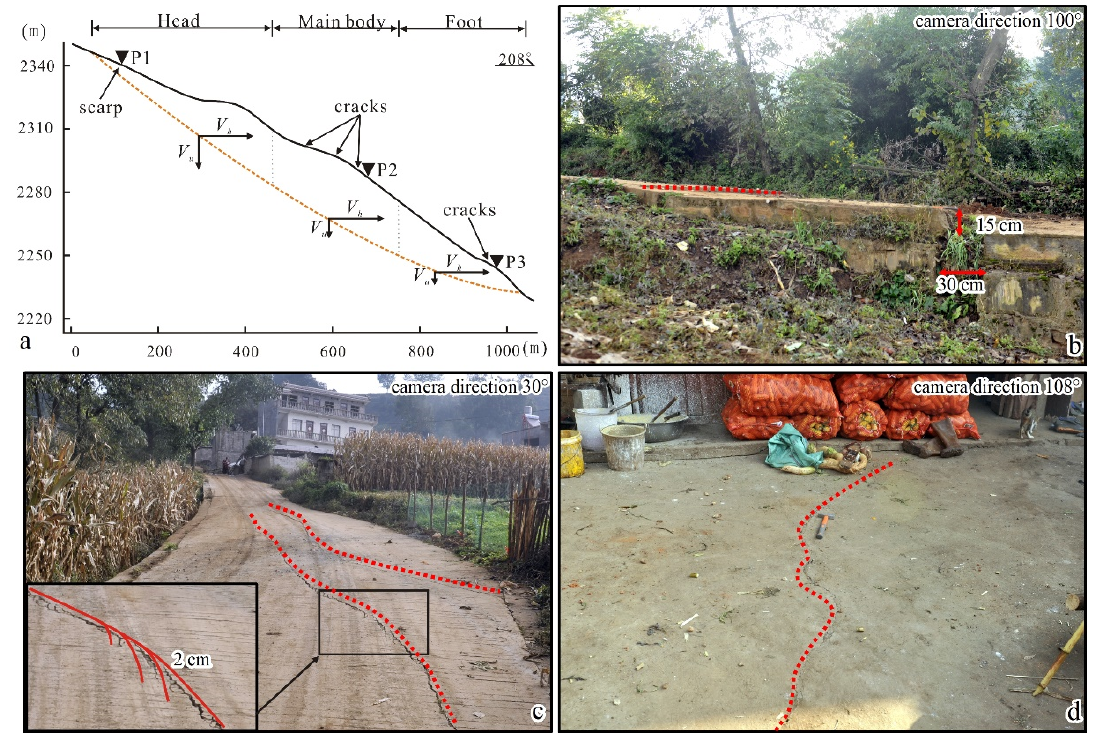
Figure 13. ( a ) Landslide profile III-III’ and location of field survey points; ( b ) deformation in the head of LYY landslide (corresponding to point P1); ( c ) shear cracks in the main body of LYY land- slide (corresponding to point P2); ( d ) tension cracks and small collapse at the foot HJP landslide (corresponding to point P3).